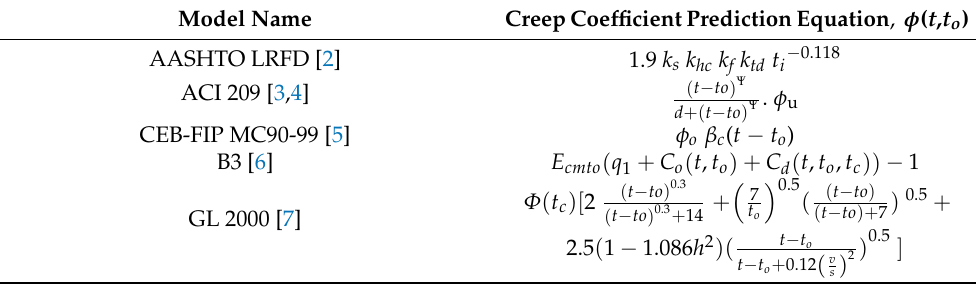
Table 5. Creep coefficient prediction